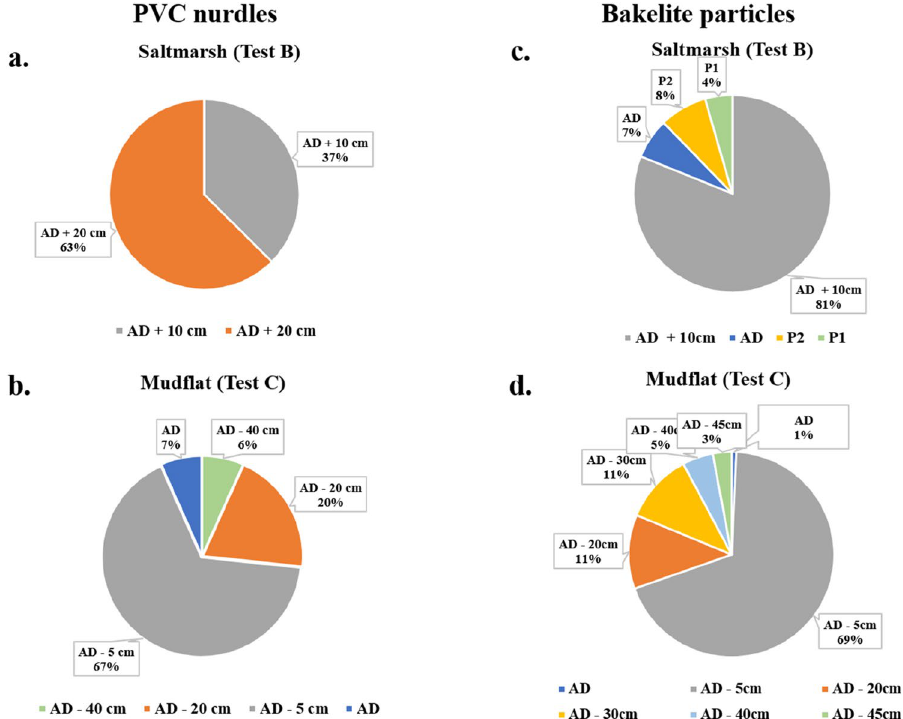
Figure 8. Distributions of the recovered microplastics from Figs. 6a,b and 7c,d, across the experimental tests. AD means Area of Deployment; the negative sign means upstream (against the water flow direction) and positive sign means downstream (in the direction of the water